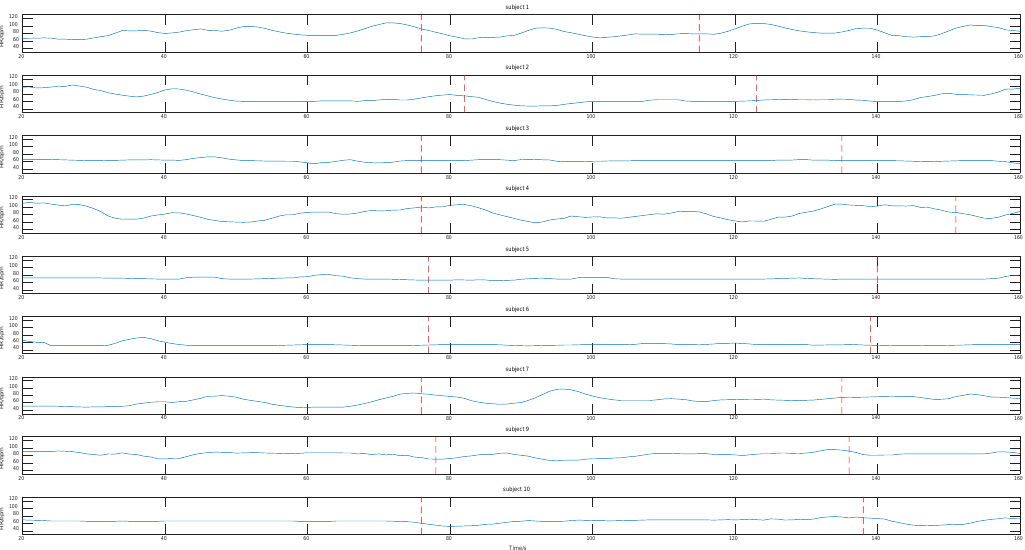
Figure 9. Heart rate changes when subjects were stimulated.